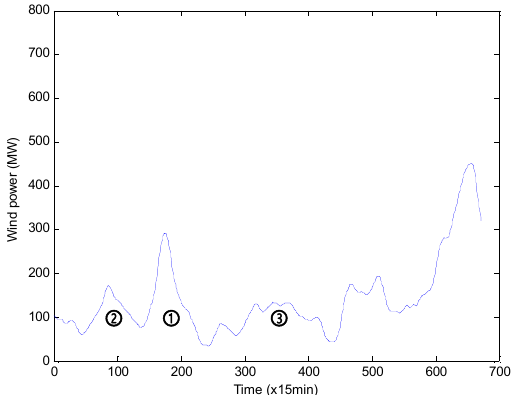
Figure 2. Wind power output curve for one week.